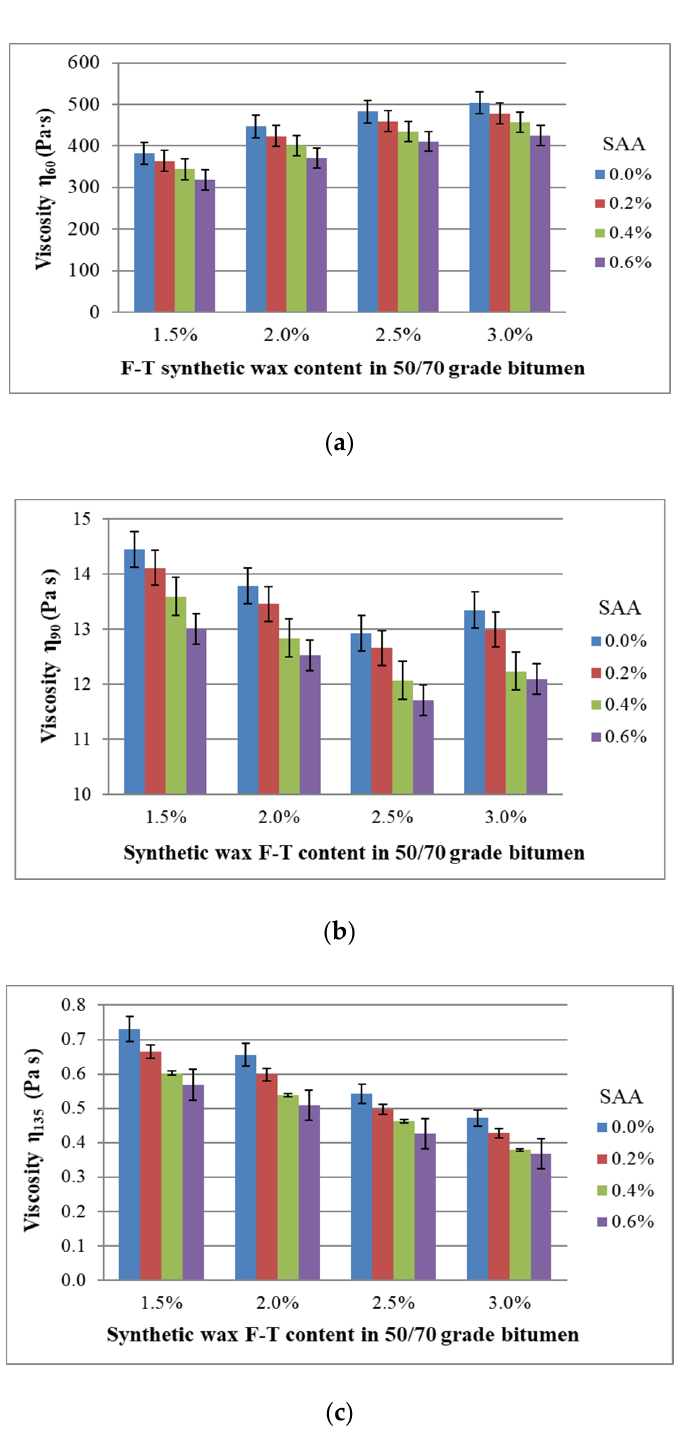
Figure 17. Relationship of dynamic viscosity of bitumen 50/70 containing F–T wax and SAA and temperature; 60 °C ( a ), 90 °C ( b ) and 135 °C ( c ).